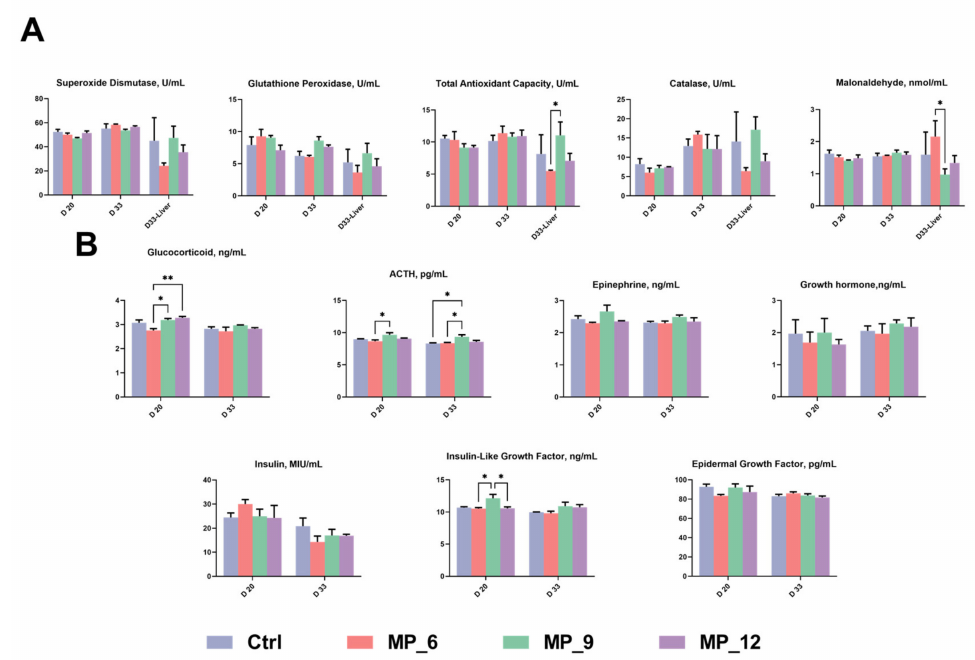
Figure 1. Antioxidant characteristics ( A ) and serum hormone contents ( B ) in finishing pigs dietary supplementation of mulberry leaf powder of varying levels. ACTH, adrenocorticotropic hormone. Ctrl, basal diet with 0% MP; MP_6, MP_9, MP_12, the basal diet supplemented with 6%, 9% and 12% MP, respectively. Data were displayed as mean ± SEM. Bar with different asterisk (*) indicated the degree of significant difference. n = 3. *, p < 0.05. **, p < 0.01.